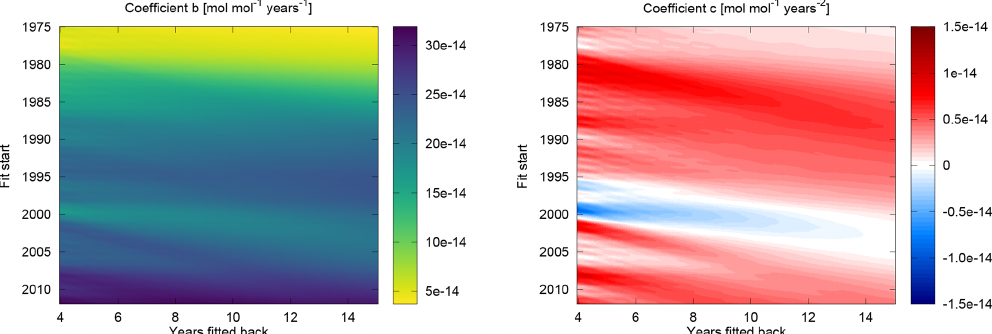
Figure 12. Coefficients b and c of the second-order polynomial fit to the SF 6 reference time series dependent on the chosen length of fit interval.